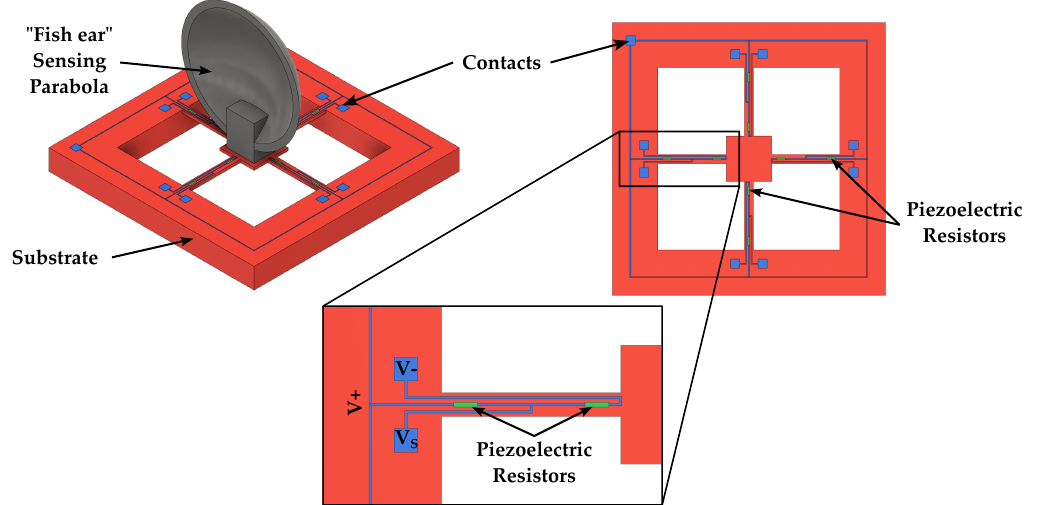
Figure 7. Schematic 3D view and top view of a piezoresistive microphone based on the “fish ear” structure proposed in [20].